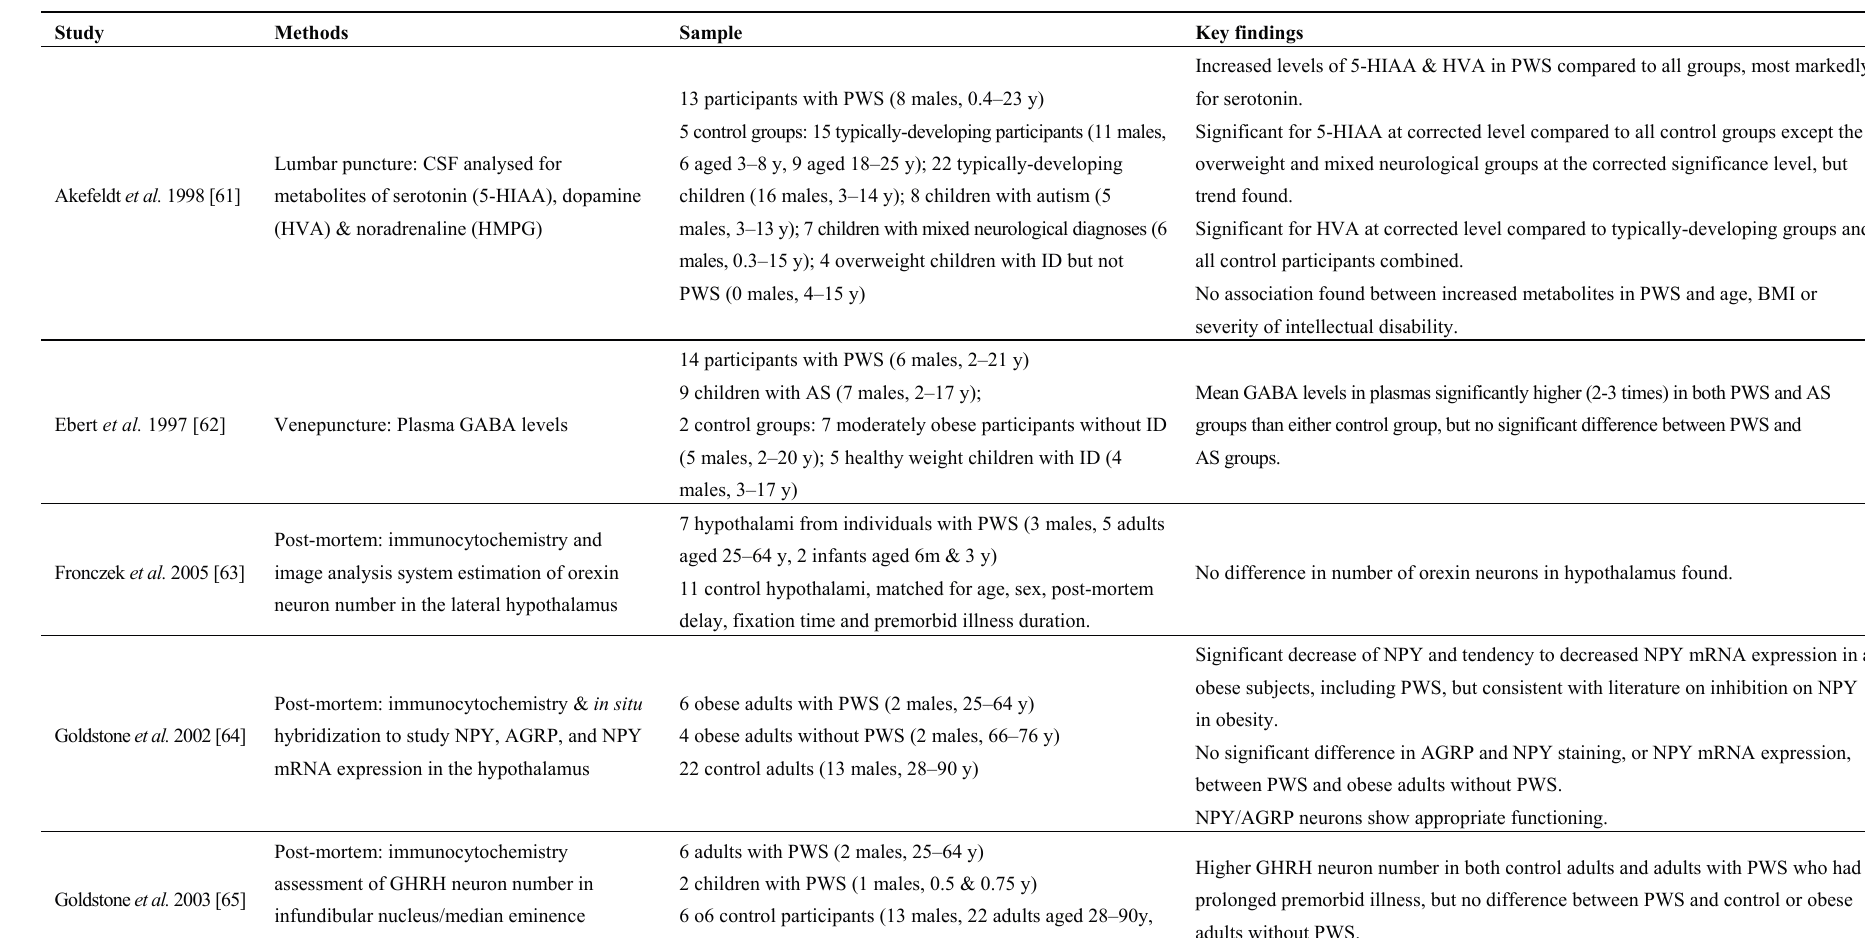
Table 3. Studies reporting neurochemical investigations and neuroanatomy at the cellular